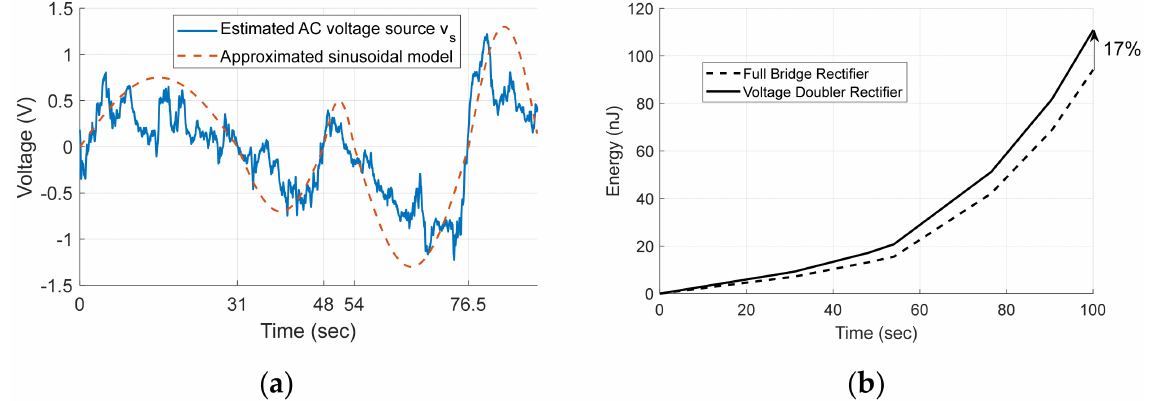
Figure 14. ( a ) Estimated voltage source; ( b ) Estimated output